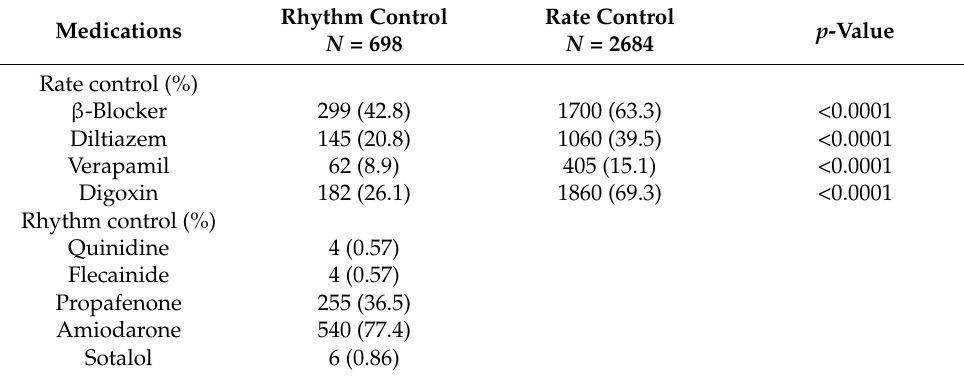
Table 2. Medications used for rate and rhythm control in AF patients.